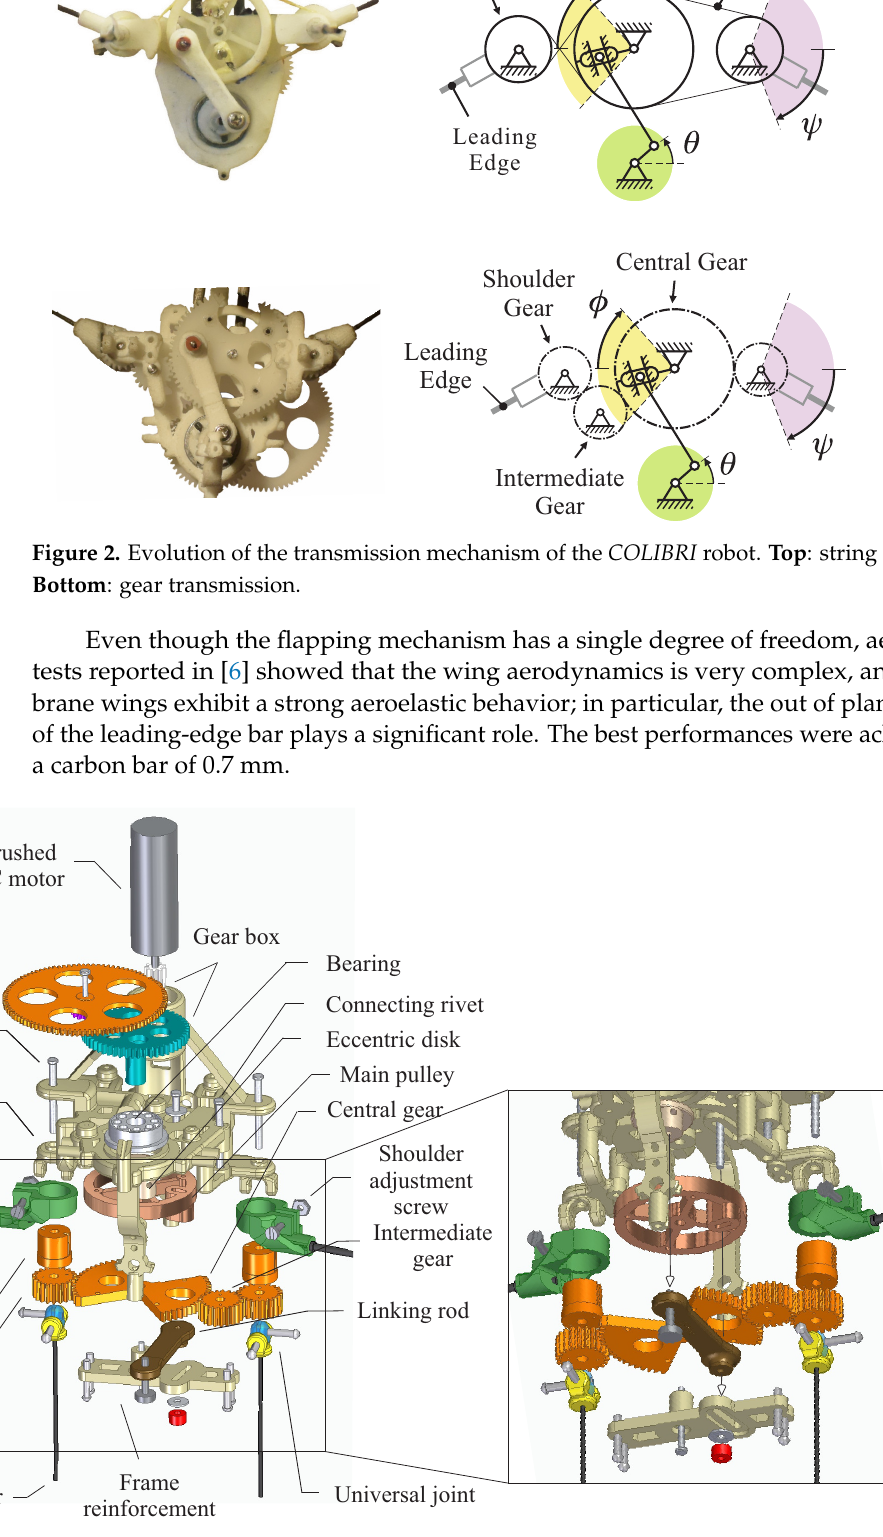
Figure 3. Exploded view of the flapping mechanism with gear transmission of the COLIBRI